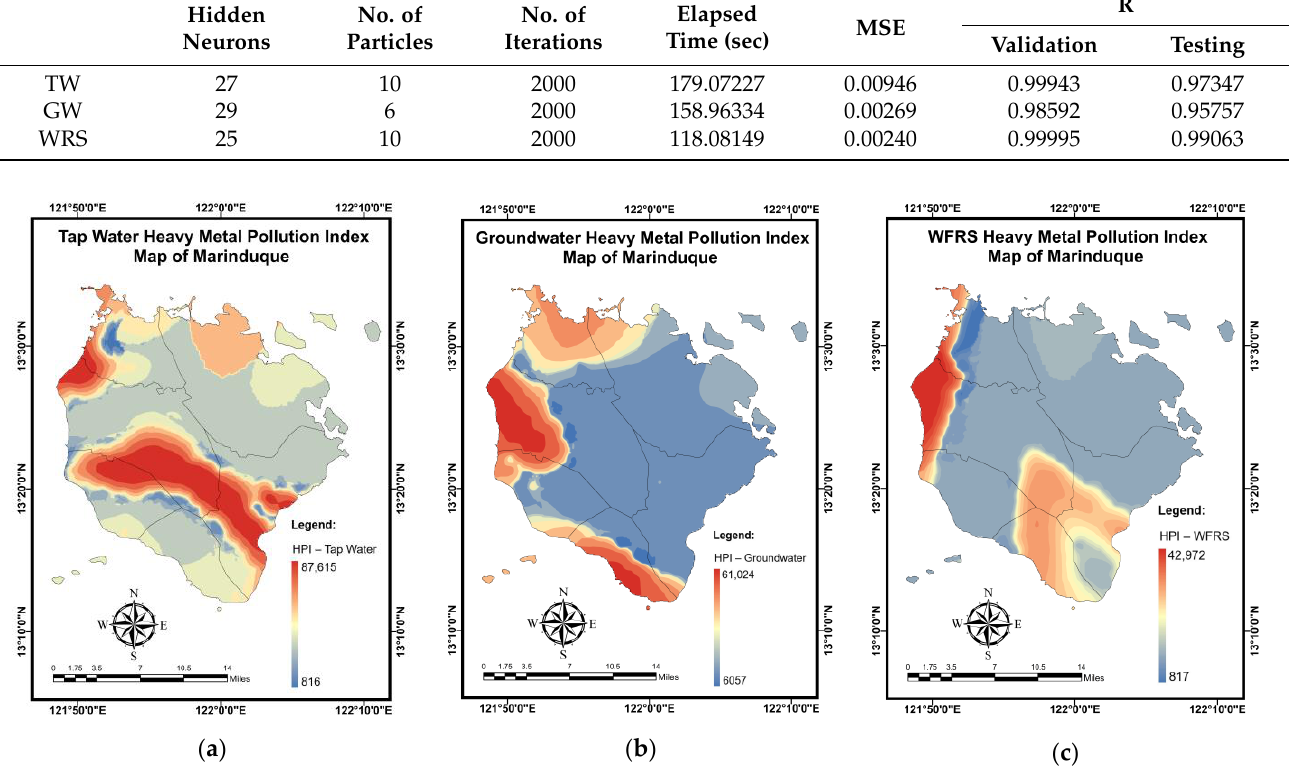
Figure 14. Spatial maps of MPI developed using MLGI approach for ( a ) TW samples, ( b ) GW samples, and ( c ) WRS samples.